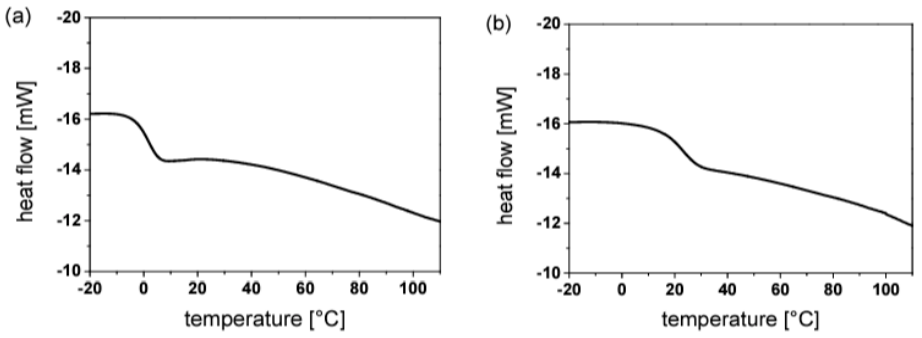
Figure 49. DSC plots of vat photopolymerized thiol-acrylate resins ( a ) prior to and ( b ) after thermal post-treatment at 180 °C for 4 h. Reproduced from Ref. [102] with permission from the Royal Society of Chemistry.